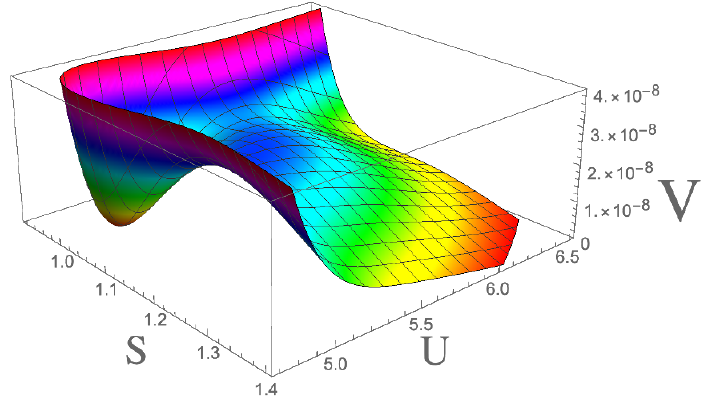
Figure 1 . The potential of the model (A.1), (A.2) with respect to the real parts of the (cid:12)eld S and U , for (cid:1) W = 0 and (cid:22) 2 = 0 in the Planck mass units. The supersymmetric Minkowski minimum with V = 0 is at S = 1 and U =